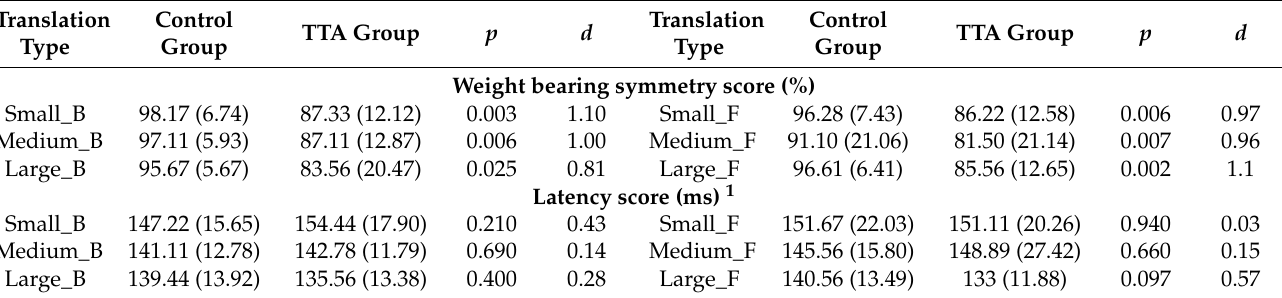
Table 2. Motor control test results.